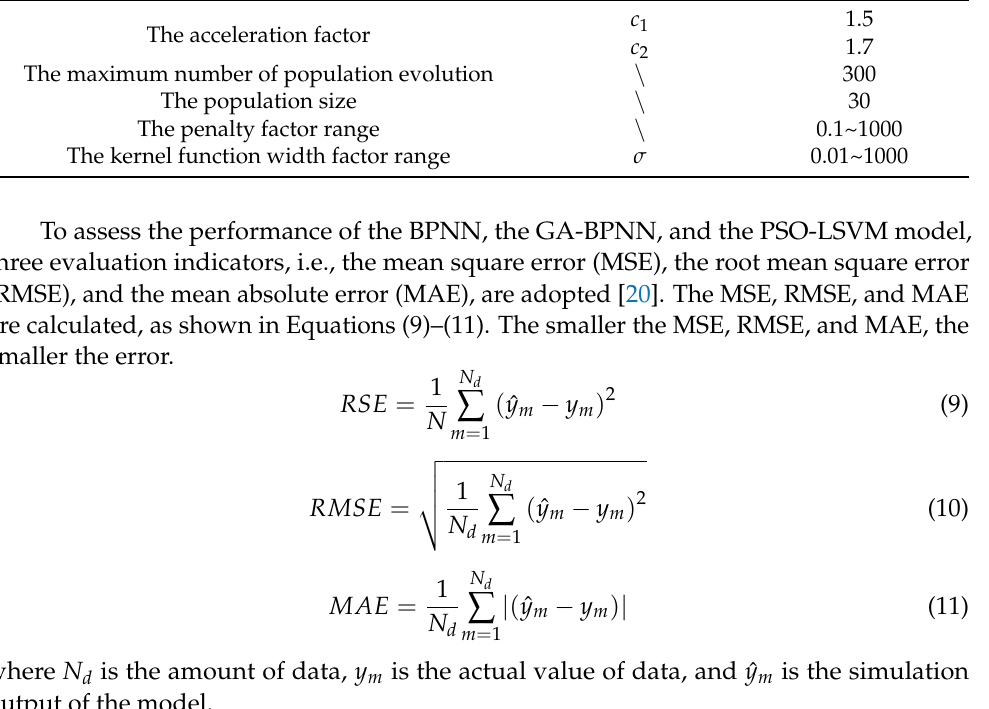
Table 3. The PSO algorithm initialization parameters.